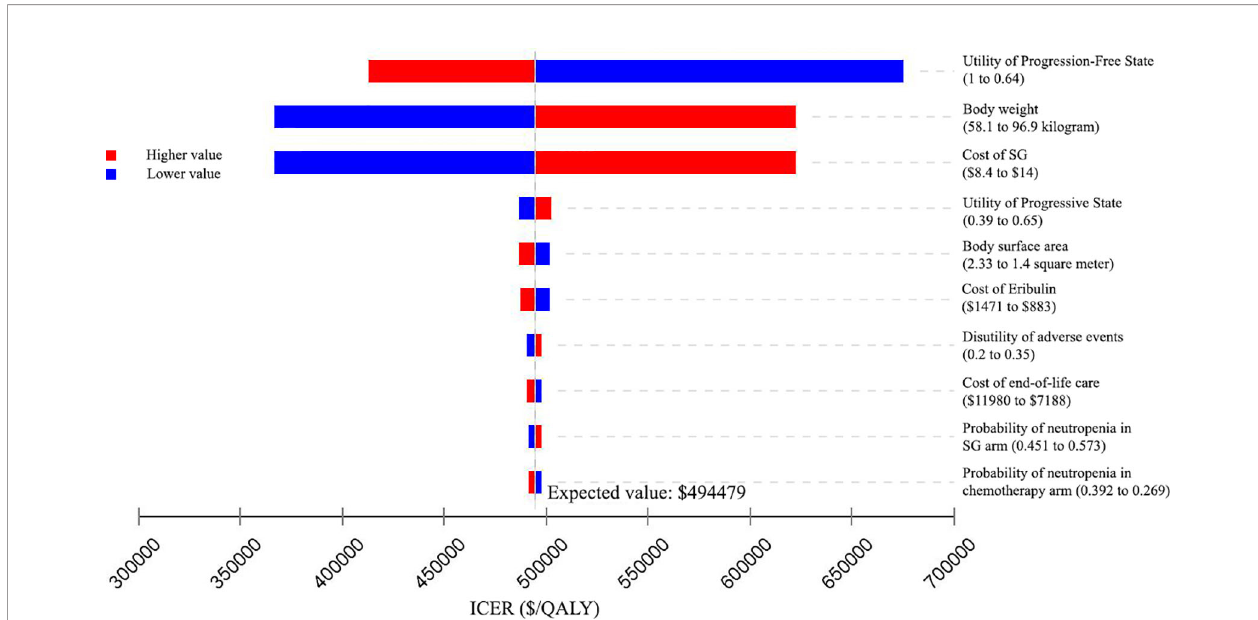
FIGURE 3 | Tornado diagram of one-way sensitivity analyses of Sacituzumab Govitecan versus single-agent chemotherapy in the treatment of metastatic triple- negative breast cancer from the United States perspective. ICER: incremental cost-effectiveness ratio; QALY: quality-adjusted life-year; SG: Sacituzumab